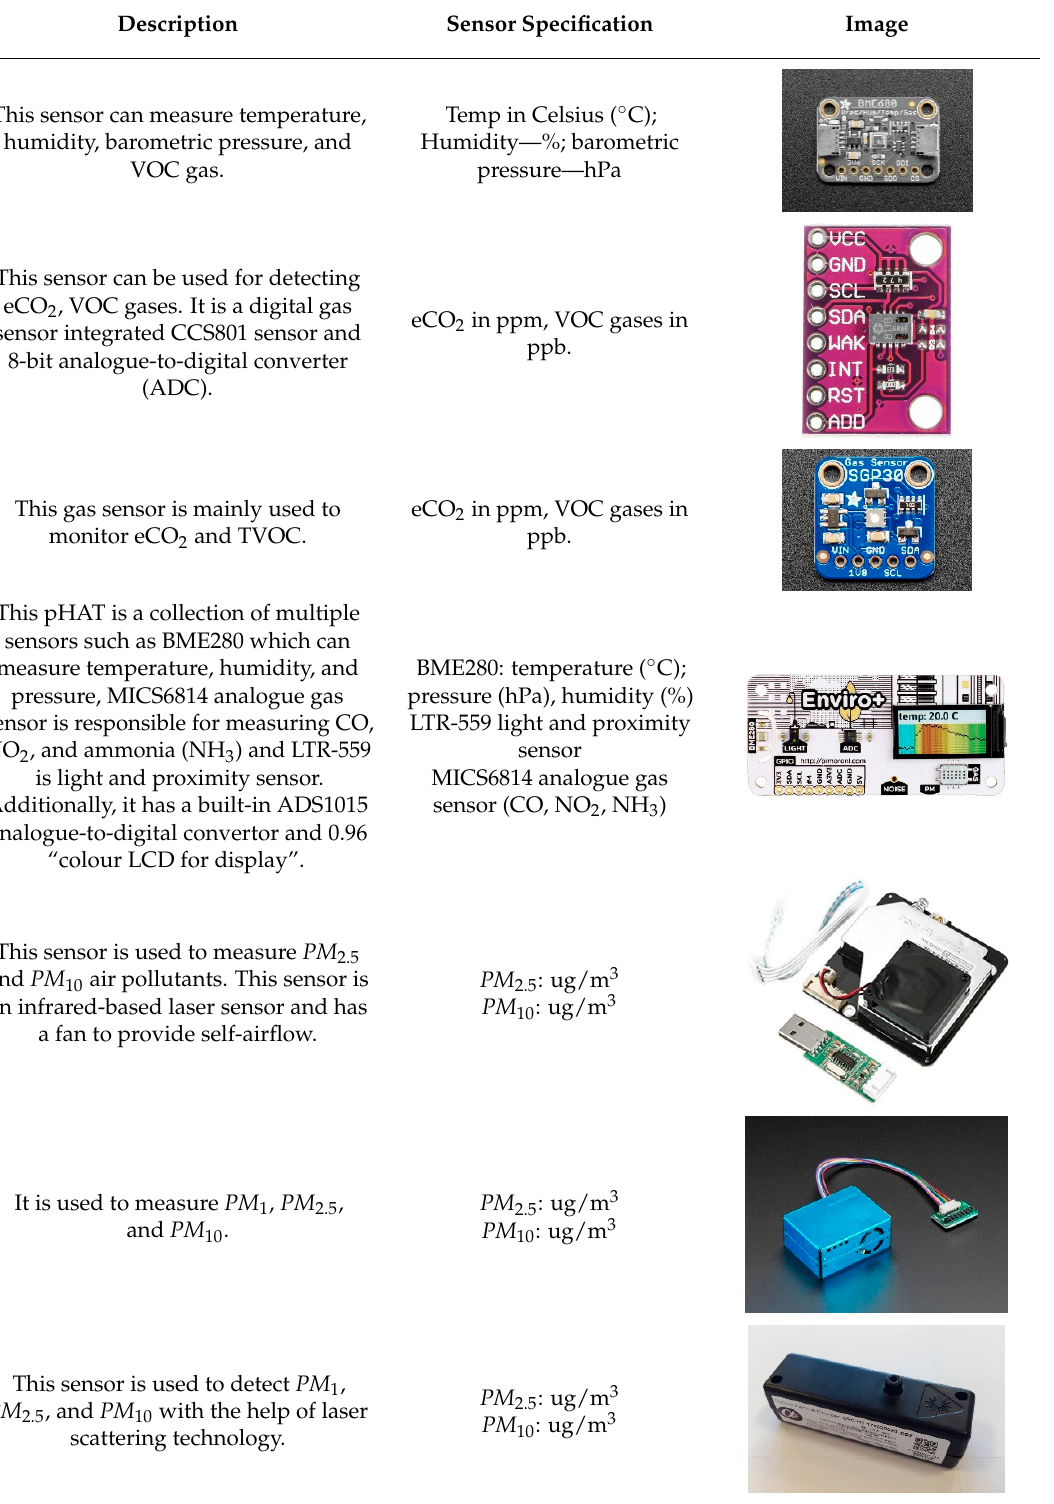
Table 1. List of candidate sensors and their details.